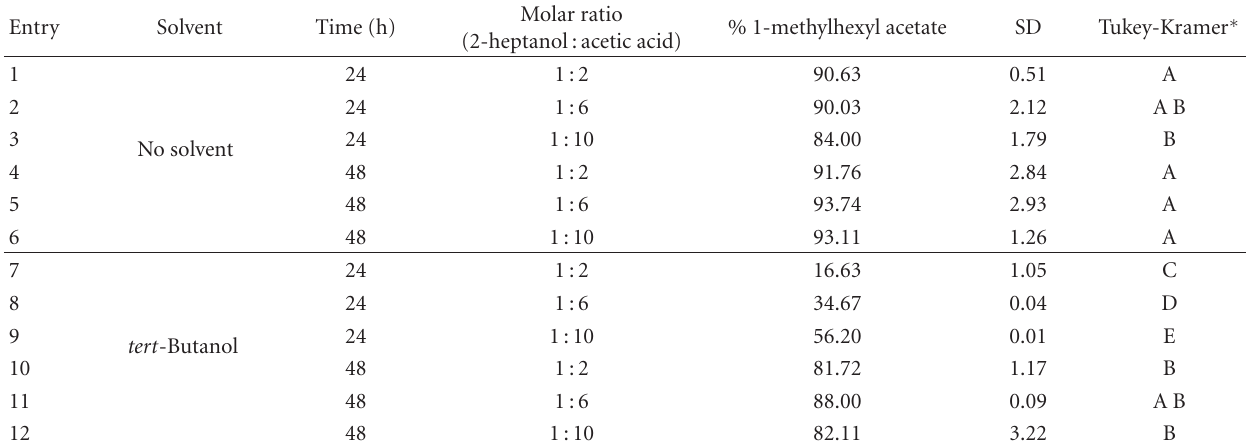
Table 1: Influence of solvent presence, reaction time, and molar ratio 2-heptanol :acetic acid in the 1-methylhexyl acetate